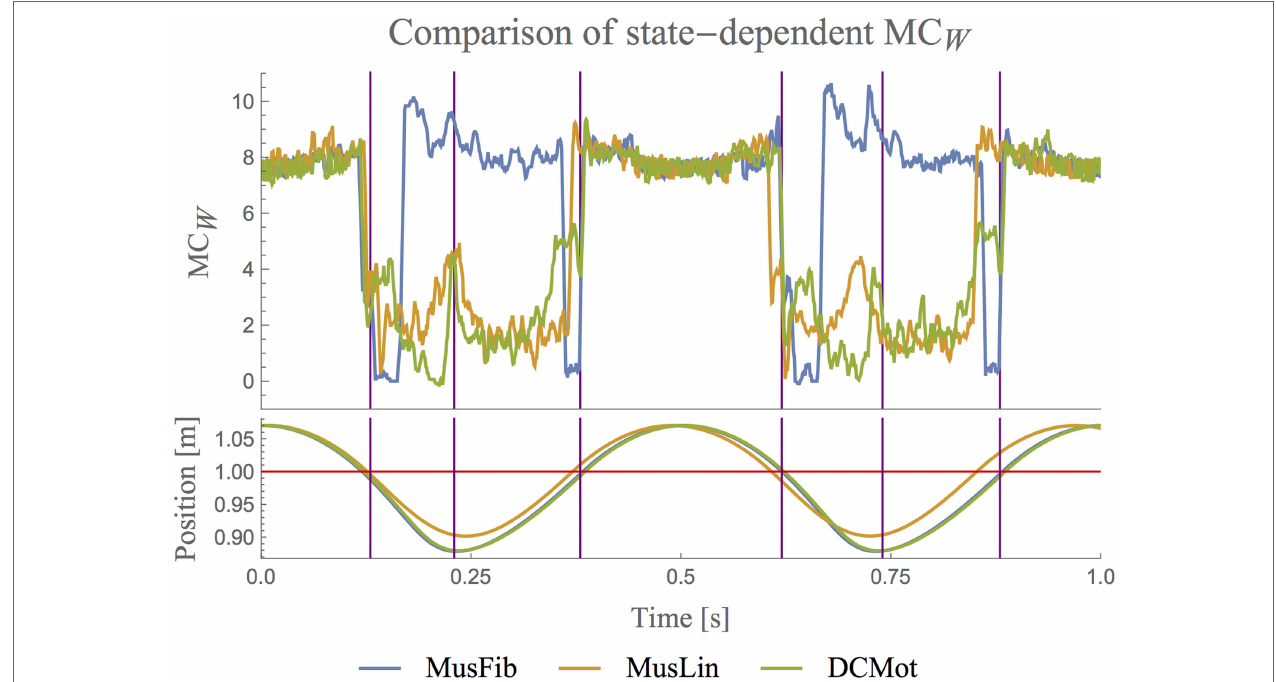
FIGURE 3 | Comparison of state-dependent MC W on the three hopping models (upper plot) . The lower plot visualizes the hopping position. The red line separates stance and flight phases. The plots only show a small fraction of the recorded data. The full data is shown in Figure 4 . For better readability, all the plots for MC are smoothened with a moving average of block size 5. The plots show that MC is high during the flight phase for all systems, i.e., whenever the behavior of the system is only governed by gravity. Only for the MusFib, MC is highest when the muscle is contracting. The other two models show low MC when the muscle is contracting and in general when the hopper touches the